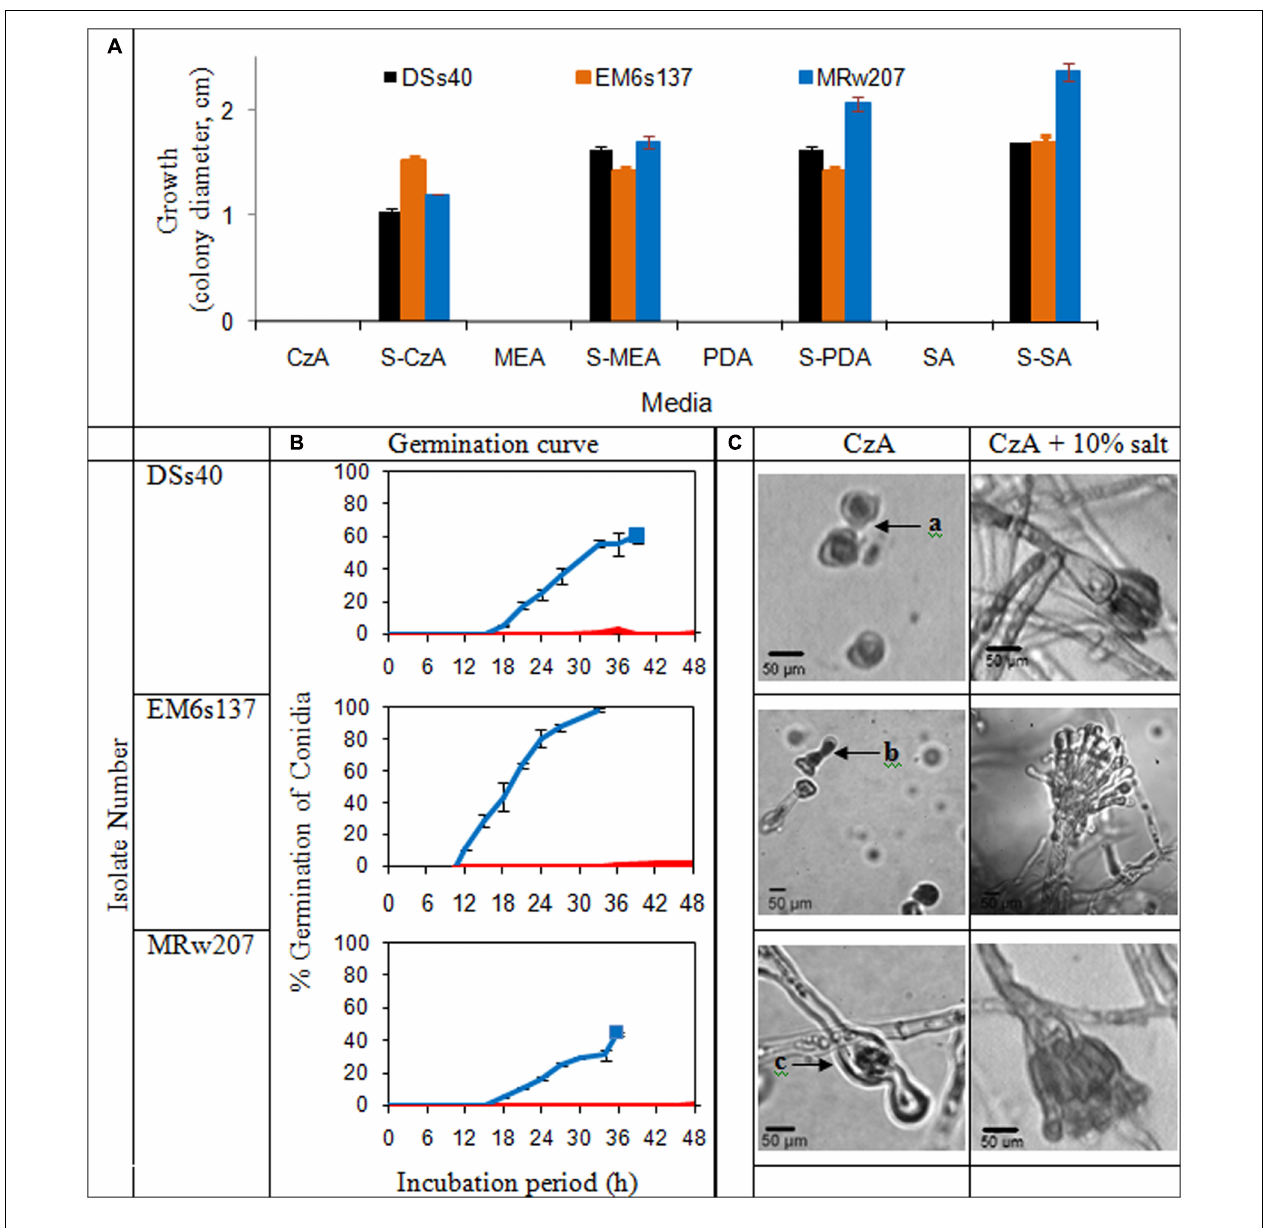
indicate termination of experiment; (C) Micromorphology of the isolates after 15 d incubation on CzA and CzA + 10% salt, showing (a): ungerminated swollen and distorted conidia, (b): conidia germinated and distorted, (c): conidia germinated and mycelia distorted with little cytoplasm, and